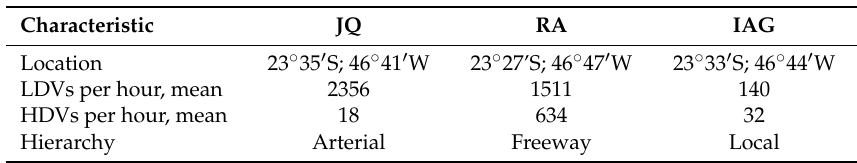
Table 1. Characteristics of the roadways